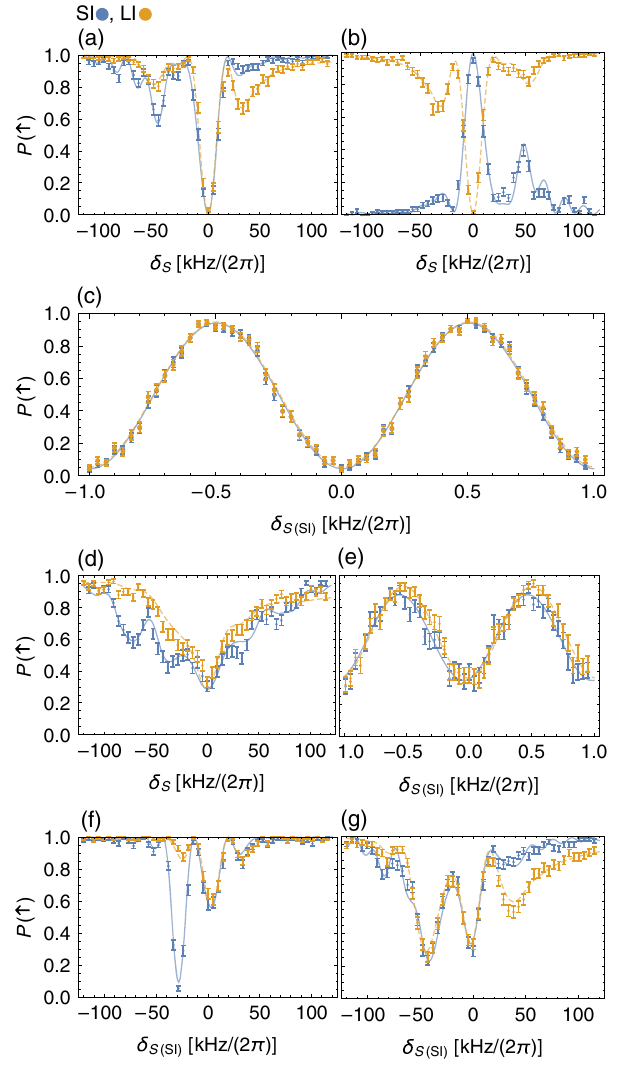
FIG. 1. Spin populations for the LI-SI pair (SI, blue; LI, orange). Fits are displayed in matching colors with solid (dashed) curves for fits to SI (LI) data. (a) Rabi spectroscopy with the SI ’ s spin state initialized to j ↑ . (b) Rabi spectroscopy with the SI ’ s SI i spin state initialized to j ↓ . (c) Ramsey spectroscopy with a SI i contrast of 0.89(1) (LI populations) and a phase shift of Δ ϕ ¼ 0 . 01 ð 1 Þ between LI and SI sinusoids. (d) Rabi and (e) Ramsey spectroscopy with Doppler cooling only; fits to Ramsey data give a contrast 0.57(2) (LI populations) and a phase shift Δ ϕ ¼ 0 . 21 ð 4 Þ between LI and SI sinusoids. Rabi spectroscopy with Ω = 2 and (g) Ω 2 Ω (f) Ω . In all figures, error bars SI ¼ MS SI ¼ MS (one sigma) are calculated assuming only quantum projection noise [35]. Each data point represents the average outcome of 200 repetitions of the experiment [100 for